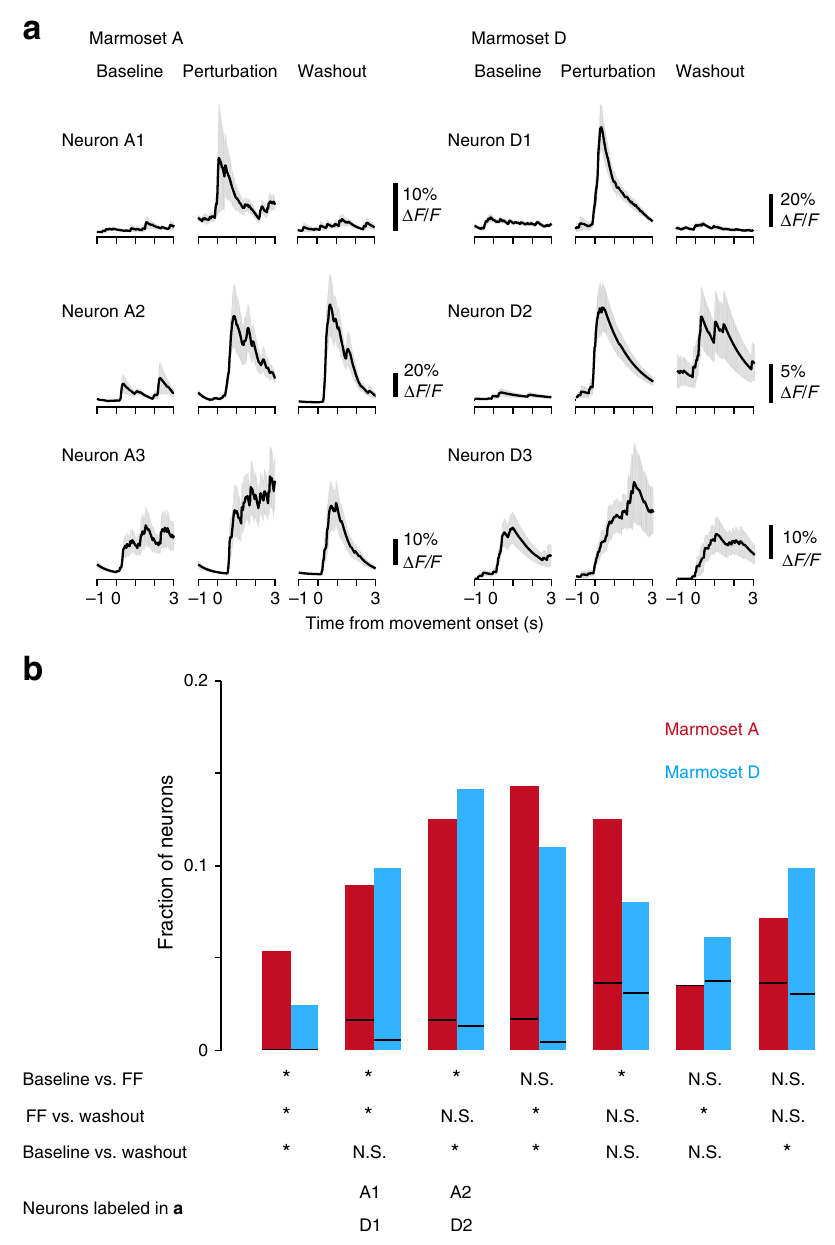
Fig. 8 Changes in neuronal activity during the force- fi eld adaptation task. a The task-relevant activity of six representative neurons (three from marmoset A and three from marmoset D). Denoised Δ F / F traces were aligned to the cursor movement onset. Lines and shaded areas represent mean ± SEM ( n = 12 – 20 successful trials occurring during imaging for each block). Neurons A3 and D3 did not show signi fi cant differences in activity between the three blocks (Kruskal-Wallis test, P = 0.53 and 0.14, respectively). b Fractions of seven groups of neurons that showed signi fi cantly different activity between the three blocks (Kruskal-Wallis test, P < 0.05) with respect to the task-relevant neurons for each marmoset. According to the signi fi cance in the post-hoc test ( P < 1 − [1 – 0.05] 1/3 ), these neurons were classi fi ed into seven groups. Red, marmoset A. Cyan, marmoset D. Asterisk indicates a statistical difference between the pair of blocks shown on the left. N.S. indicates a non-statistical difference. The bottom indicates which groups of neurons (A1, A2, D1, and D2) in a were assigned to. Black line in each fraction box indicates the 95th percentile of the fraction obtained from trial shuf fl ed data. Fractions, except for that in the second row from the right in marmoset A, were larger than the corresponding 95th we imaged super fi cial layers. The super fi cial layers of the motor cortex receive strong signals from the sensory cortex 30,43 , while layer 5 neurons include corticospinal neurons, which are directly involved with muscle activity. Thus, the super fi cial and deep layers may show different neuronal activity and plasticity, as we previously suggested for the mouse motor cortex 3 . In the force- fi eld adaptation task, we found that some neurons in the local area changed their mean task-relevant activity during the